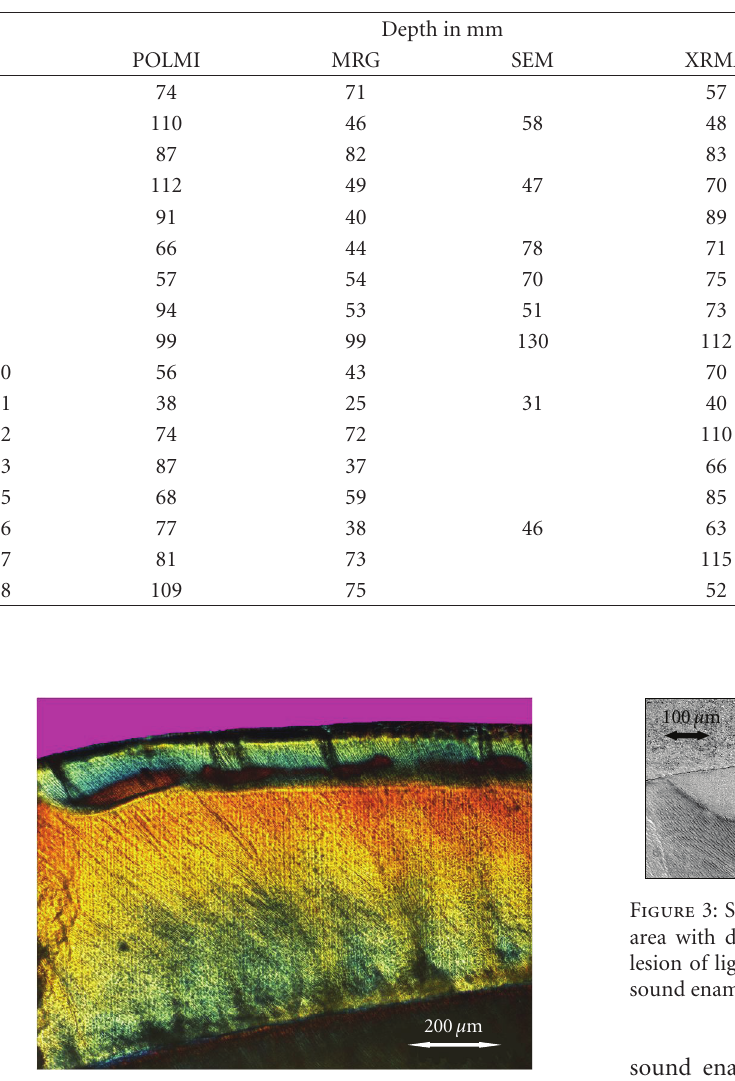
Table 1: Mean of depth of lesions (in micrometer) in all specimens, measured in polarized light microscope (POLMI), microradiographs (MRG), SEM, and XRMA images. Appearance of lesions; chalky and rough surface, chalky and smooth surface, and normal color with a smooth surface. Age of the individuals in years when tooth was extracted.